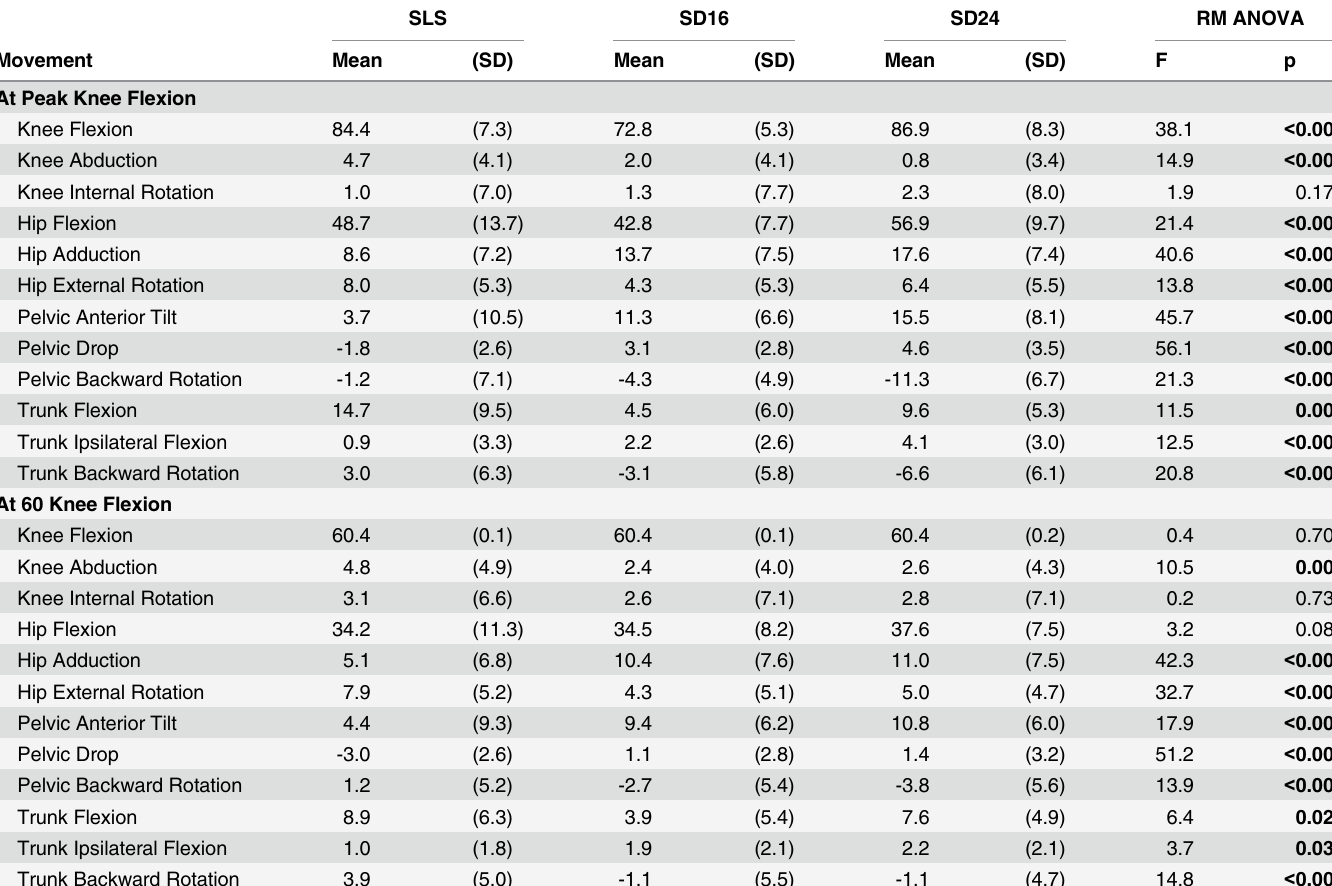
Table 1. Mean and standard deviation (SD) for each variable (degrees) for each task at the two time points.